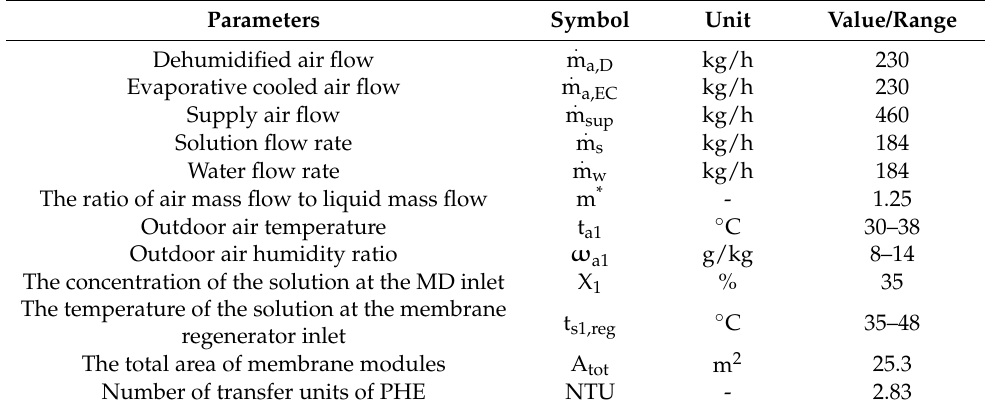
Table 6. Operating parameters for the membrane-based fresh air processing system.